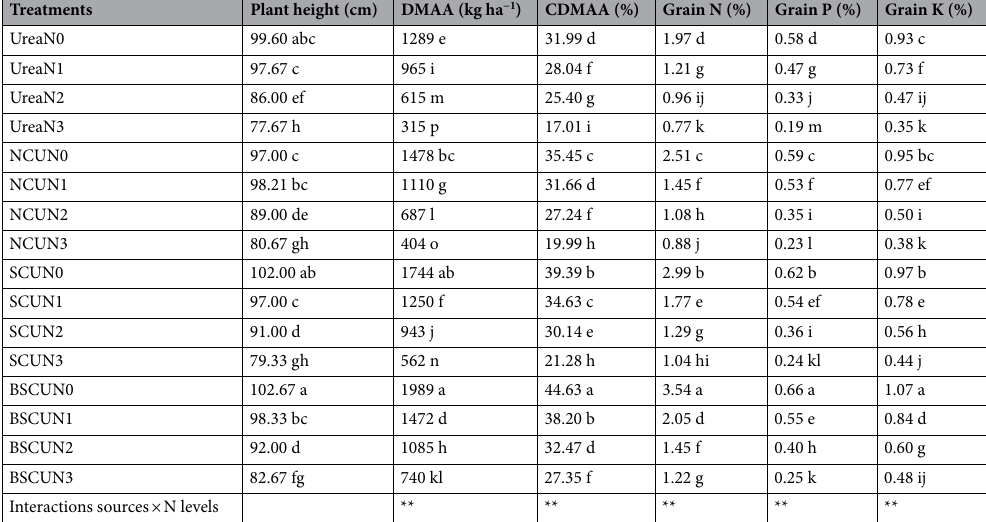
Table 1. Effect of different slow release fertilizers and N rates on plant height (cm), DMAA (kg ha −1 , CDMAA (%) and grain NPK% N0 130 kg N ha −1 , N1 117 kg N ha −1 , N2 104 kg N ha −1 , N3 94 kg N ha −1 , BSCU bioactive sulfur coated urea, SCU sulfur coated urea, NCU neem coated urea, CDMAA dry matter accumulation contributed amount after anthesis, DMAA accumulated dry matter after anthesis